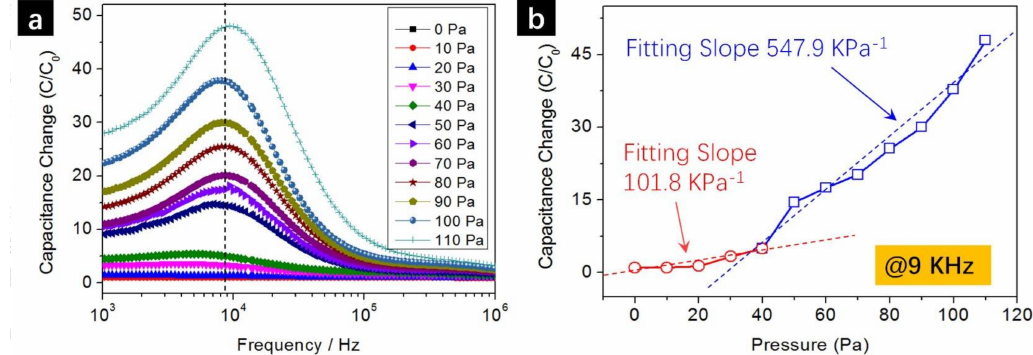
Figure 3. ( a ) Capacitance change C / C 0 versus frequency curves at different applied pressures within 0–110 Pa; ( b ) Capacitance change C / C 0 versus pressure curves and their linear fitting results showing the pressure sensitivity as high as 547.9 KPa − 1